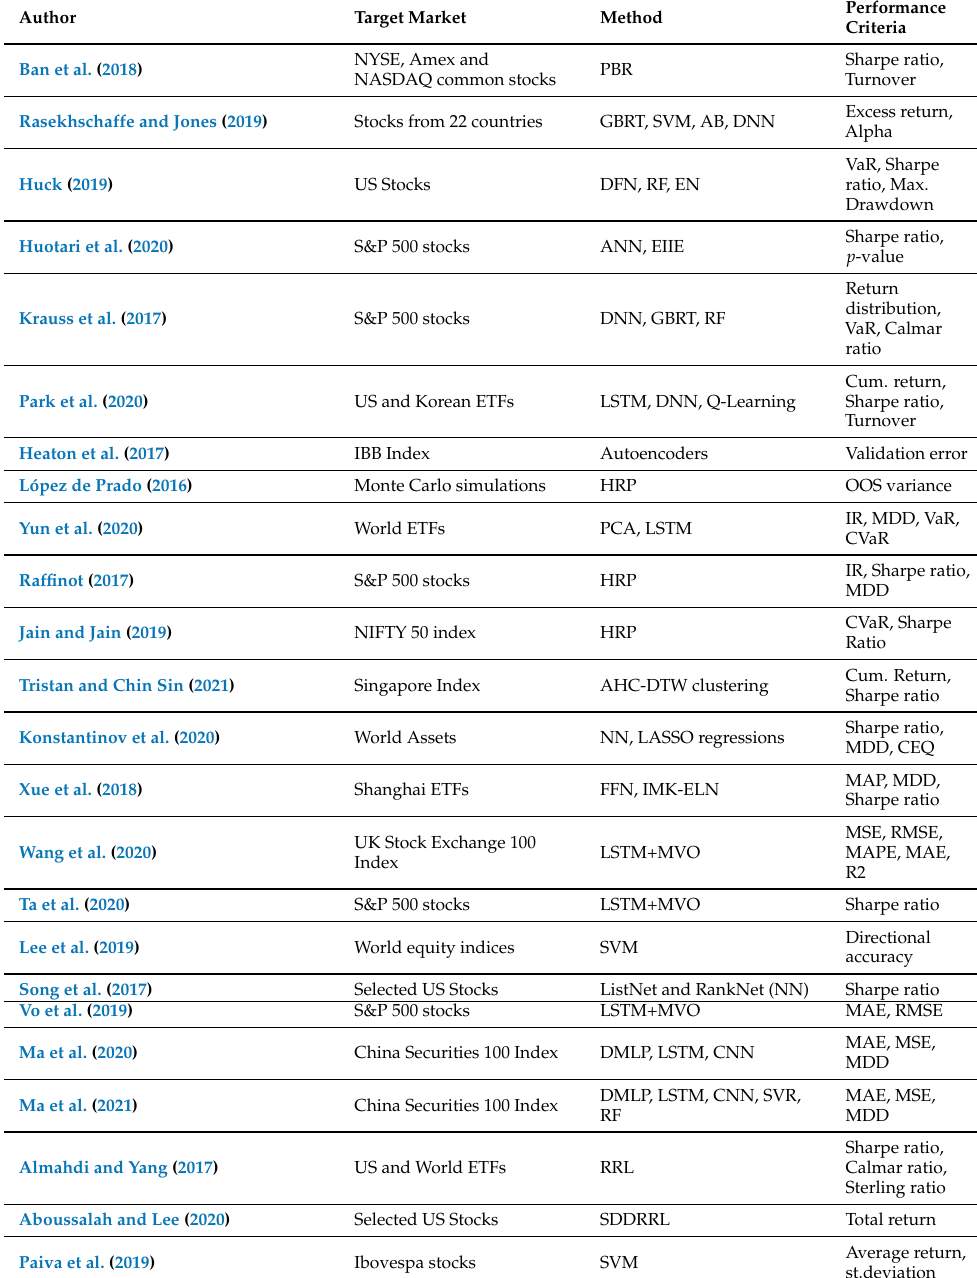
Table 4. Selection of papers for portfolio management. Value at Risk (VaR), Conditional Value at Risk (CVaR), Maximum Drawdown (MDD), Certainty Equivalent Return (CEQ), Mean Absolute Percentage Error (MAPE), Mean Absolute Error (MAE), Out-of-the-Sample (OOS), Mean Standard Error (MSE), Maximum Drawdown